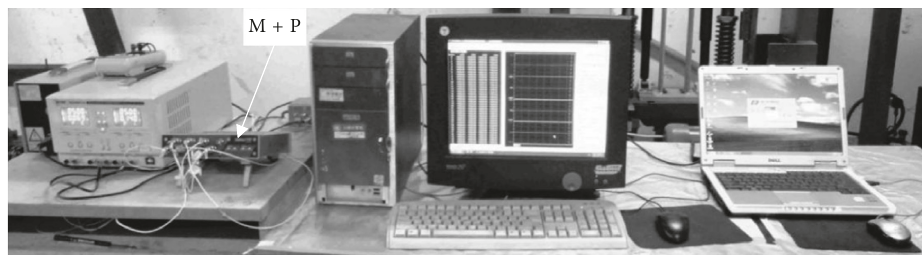
Figure 17: Signal acquisition